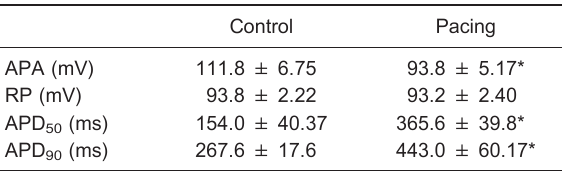
Table 4. Bioelectric properties of hearts in control and pacing groups.